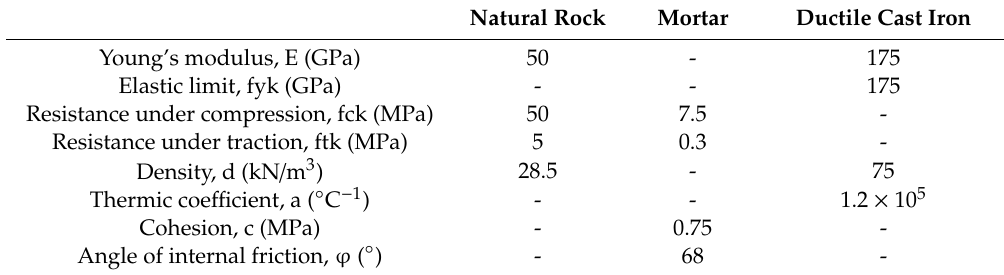
Table 1. Evaluation of construction materials for execution of the calculation models. Natural Rock